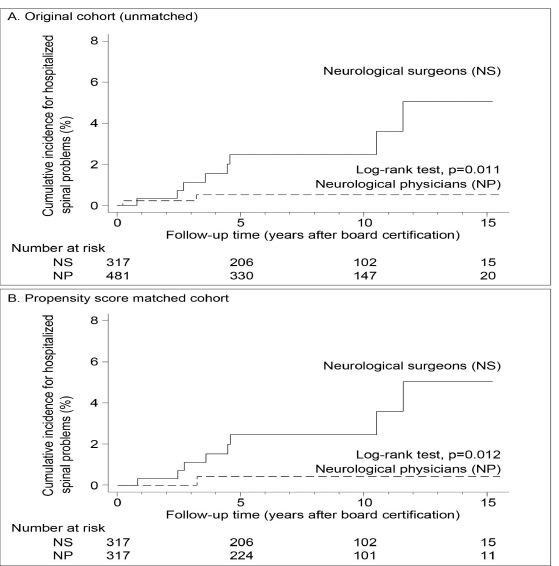
Figure 2. The Kaplan-Meier plot and Log-rank test for the incidence rates of spinal problems in NP and NS in the original cohort and propensity score matched cohort